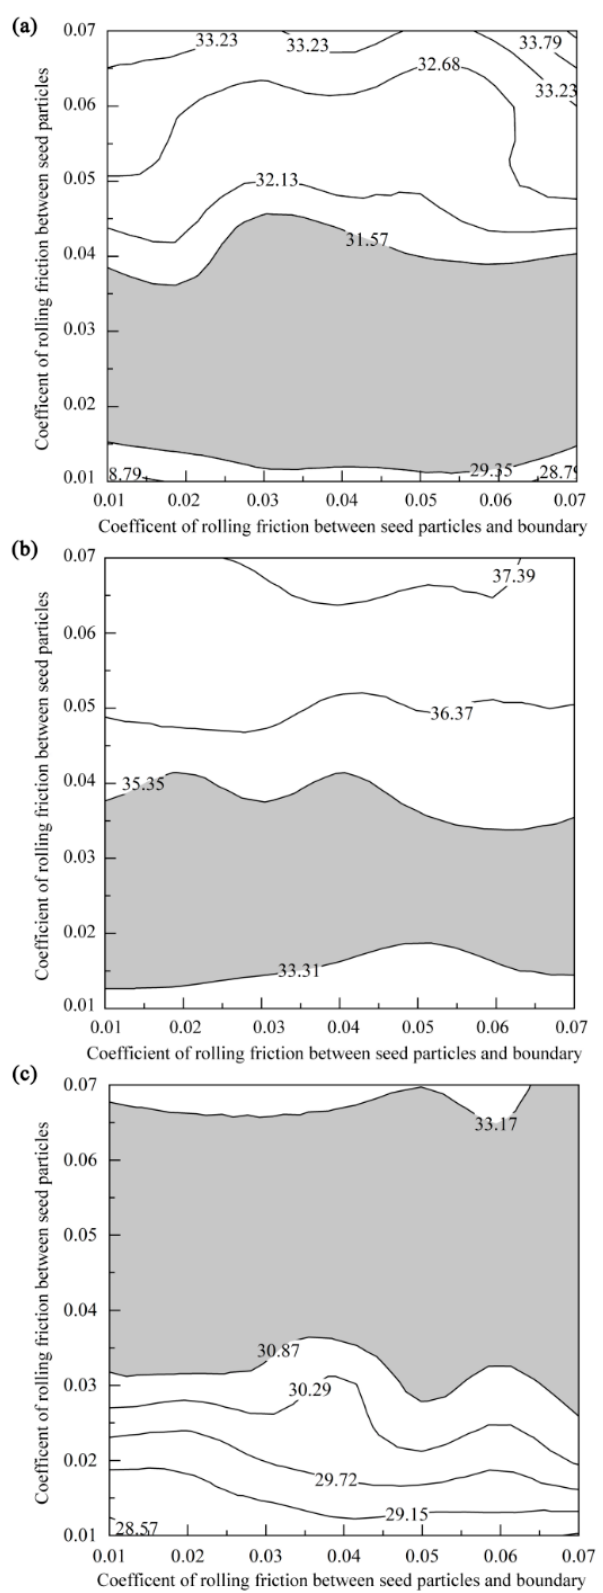
Figure 9. Sensitivity of coefficients of rolling friction between seed particles and between seed particles and boundary to piling angle for three varieties: ( a ) Liangyu99, ( b ) Xianyu 335 and ( c ) Zhengda 999.